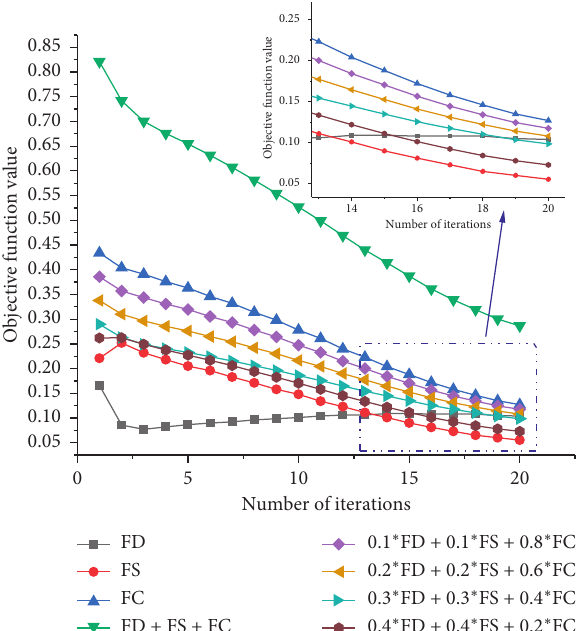
Figure 19: The convergence results of CC-CSI with fixed weights for “ U -shaped” groove.